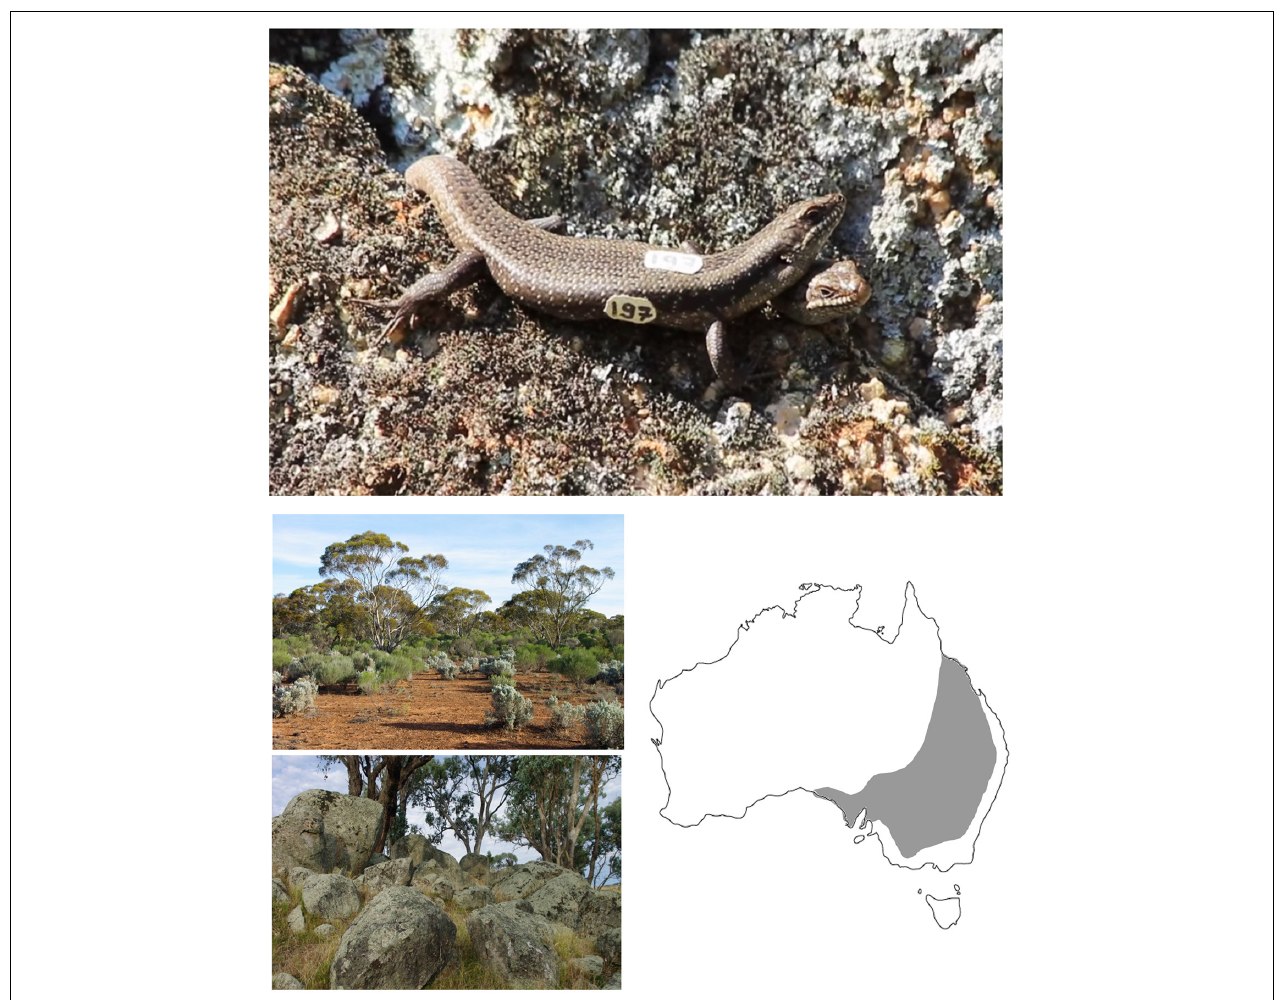
FIGURE 1 | Tree Skinks ( Egernia striolata ) aggregate within crevices and hollows in rocks and trees (top; photo credit James O’Hanlon). They inhabit both forest and rocky habitats (bottom left; two examples of Tree Skink habitat photographed by Julia Riley) within their range in eastern Australia (bottom right; range map adapted from Cogger,